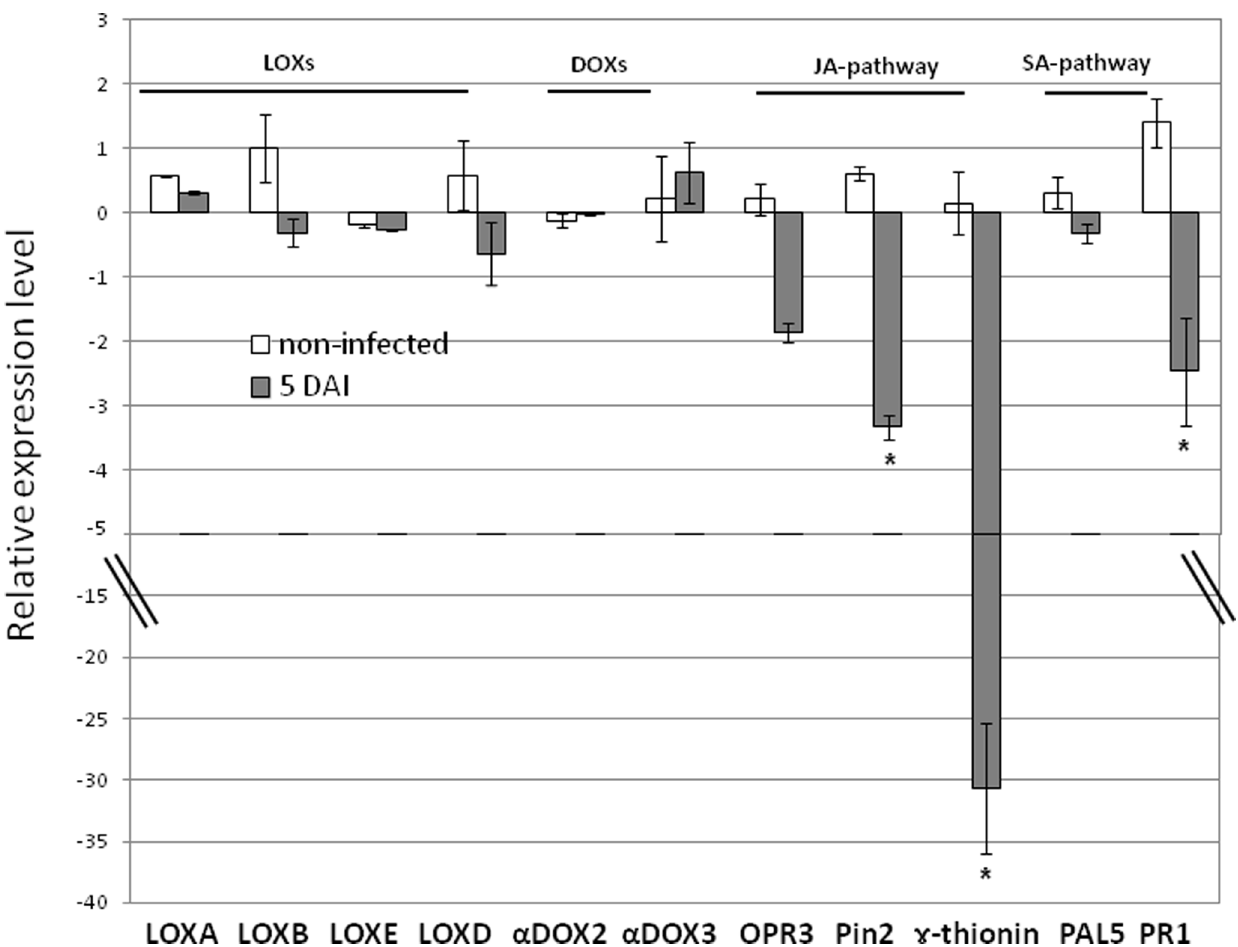
Figure 6. Analyzing Mj-FAR-1 functions in manipulating plant defense pathways. Expression level of 11 defence-related target genes in mj-far-1 expressing root line far-1 E1.1 compared with vector control prior and 5 DAI with Meloidogyne javanica . Total RNA was prepared from Vector 11.5 transformed control roots and roots expressing mj-far-1 with/without infection. The graph shows the mean and standard error of the relative amount of transcripts of these genes in mj-far-1 expressing roots ( far-1 E1.1) in comparison with vector transformed control roots (Vector 11.5) growing under the same conditions (vector control expression level set at zero). All target genes were normalized using the normalisation factor calculated as the geometric mean of the expression levels of three tomato endogenous reference genes 18S , actin and b -tubulin . Each reaction was performed in triplicate and the results represented the mean of two independent biological replicates. Statistical significance of the differences between far-1 E1.1 and Vector 11.5 transformed control roots were determined by Tukey-Kramer multiple comparison test, and significant differential expression (P # 0.05) is indicated with asterisks. The experiments were repeated three times with similar results.